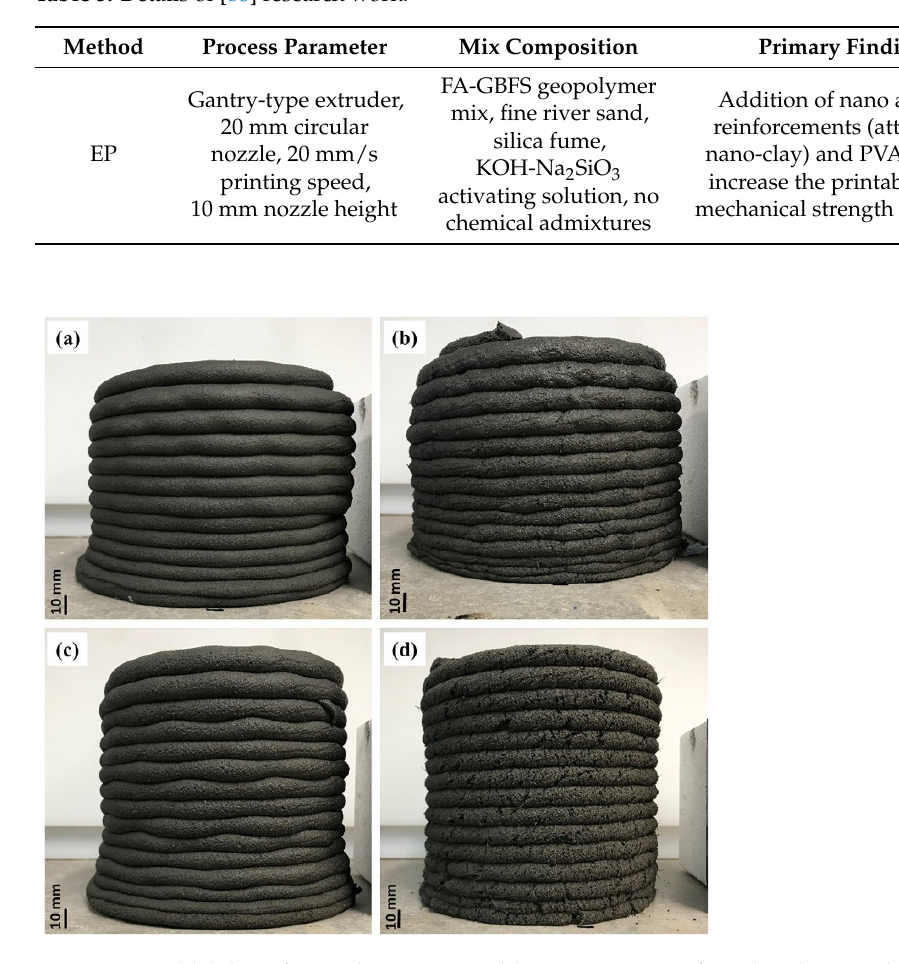
Table 6. Details of [89] research